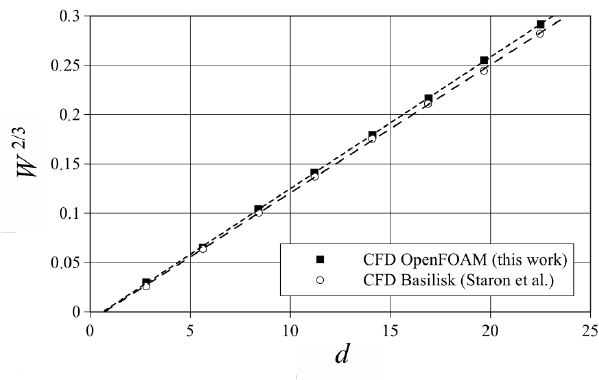
Figure 1. Discharge rate using Basilisk and OpenFOAM and a linear fitting to retrieve the Beverloo correlation.